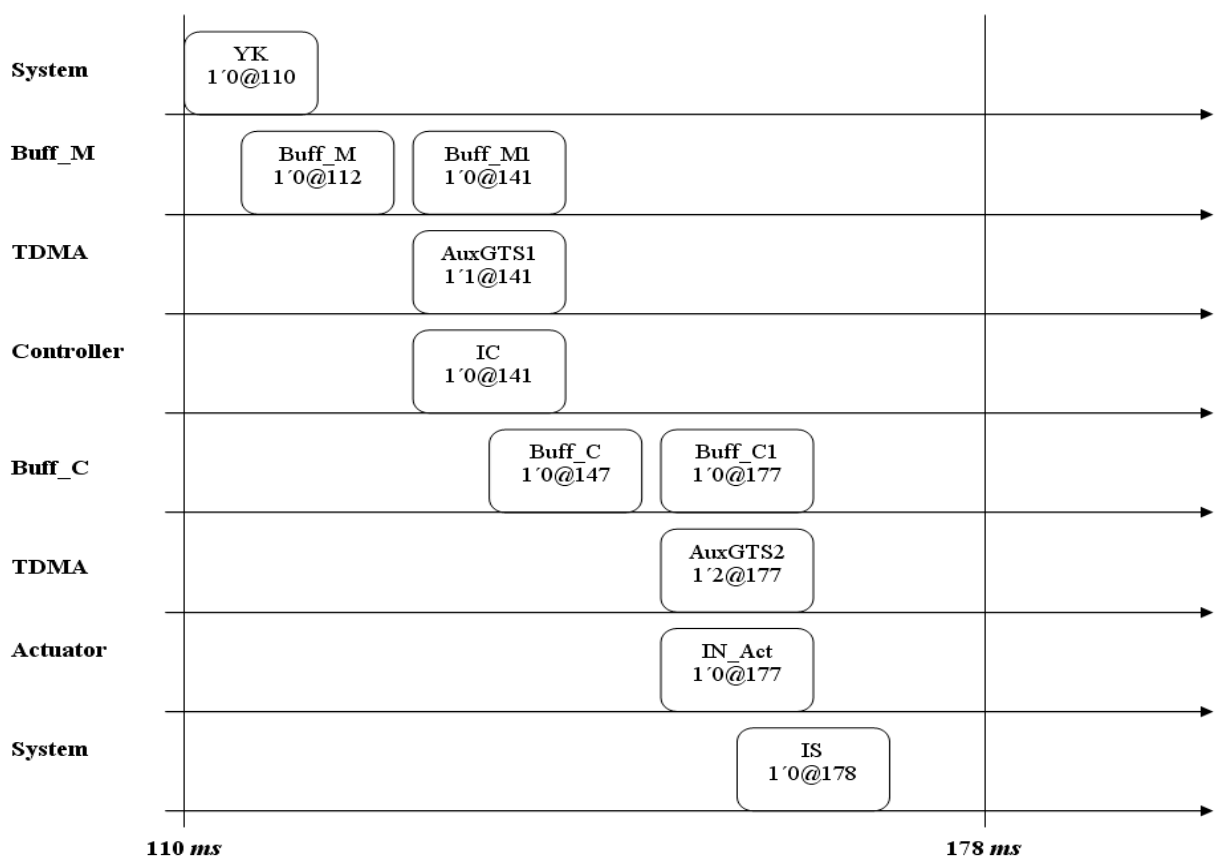
Figure 8. Simulations results from the CPN model between 110 and 178